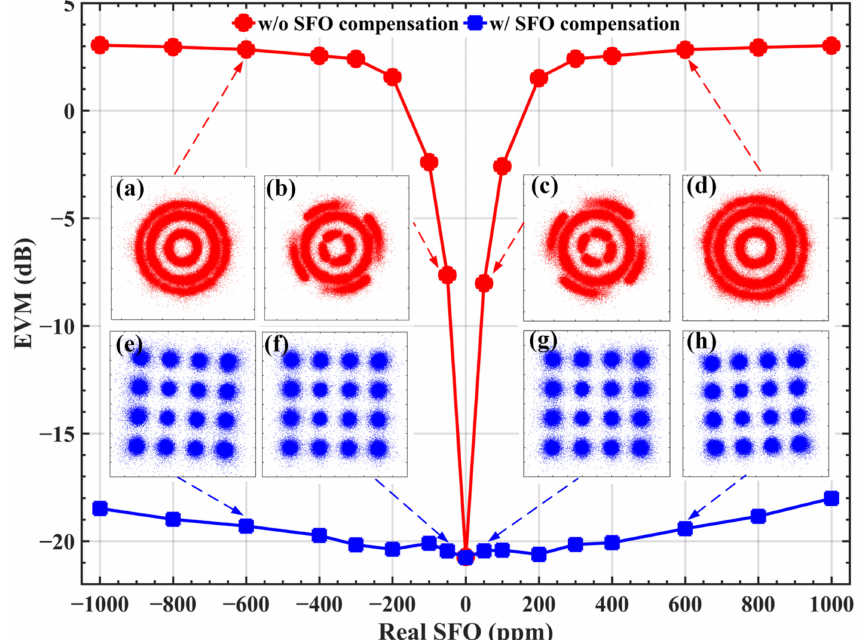
Figure 6. EVM versus sampling clock frequency offset. Subfigures show the 16-QAM constellations ( a – d ) without SFO compensation; ( e – h ) with SFO